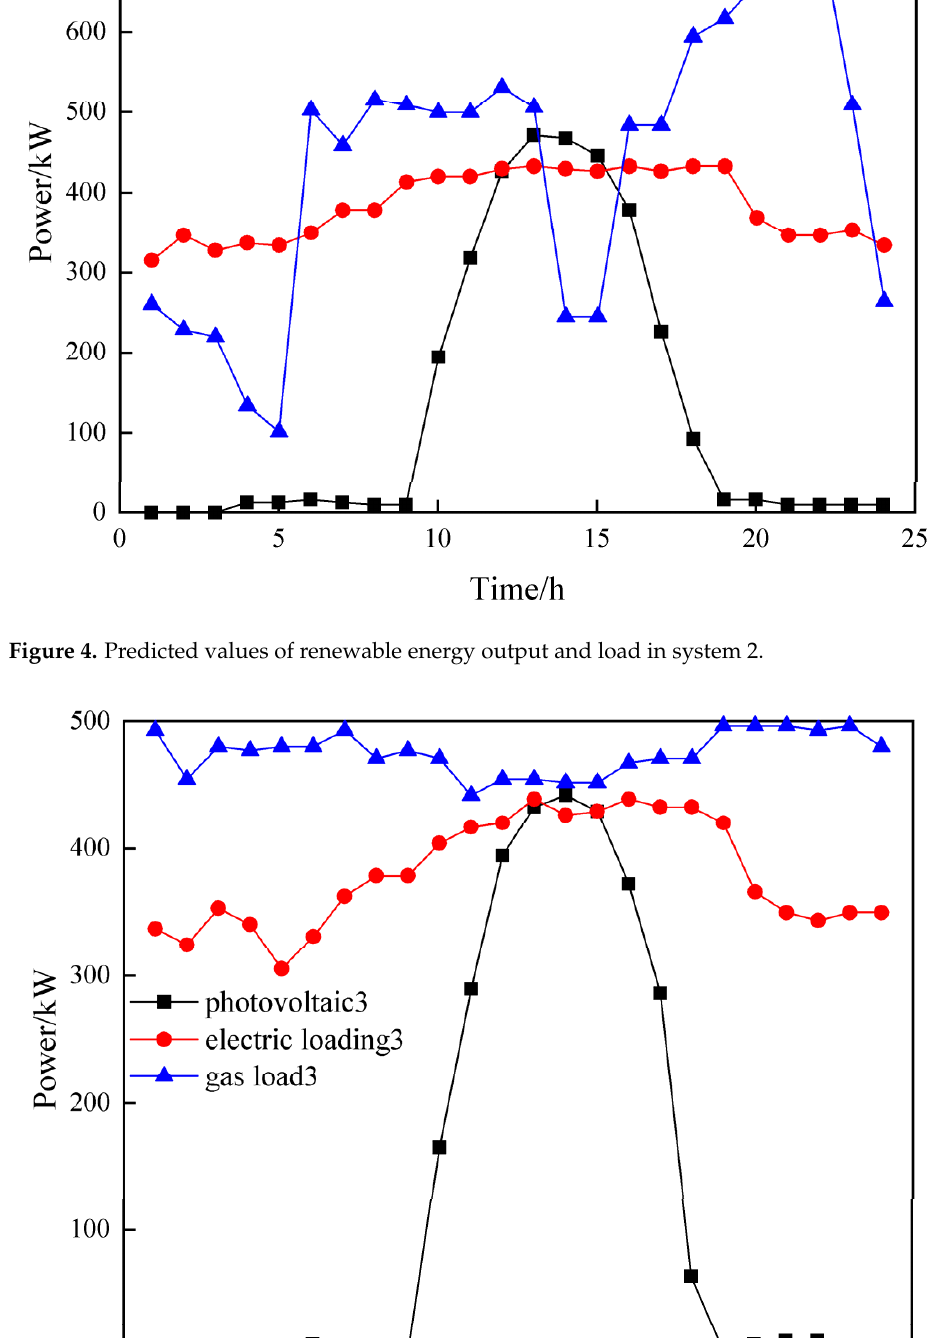
Figure 5. Predicted values of renewable energy output and load in system 3.